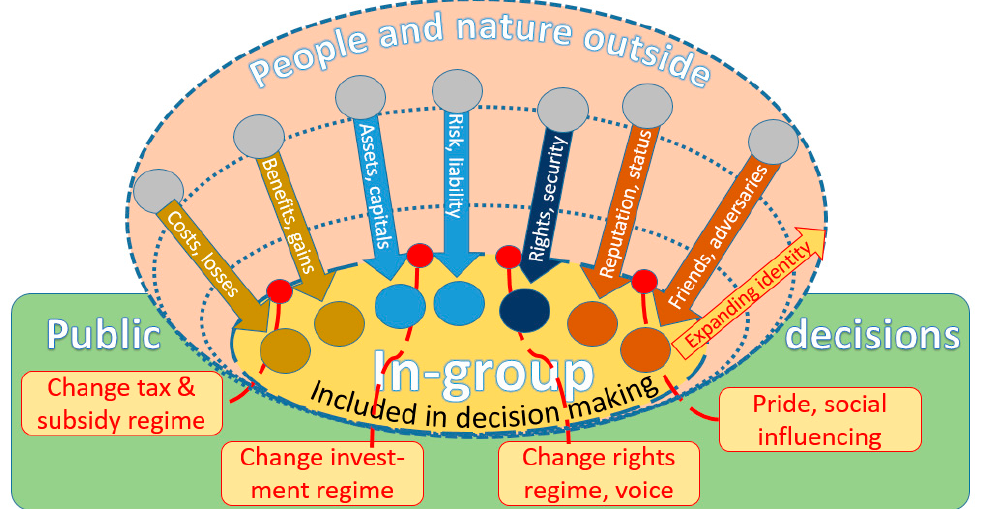
Figure 4. Visualization of the various approaches to internalize externalities in human decision making, which tends to consider consequences (costs and benefits) for an in-group but not for people and nature beyond this emotional inner circle unless efforts to expand the inner circle are effective.